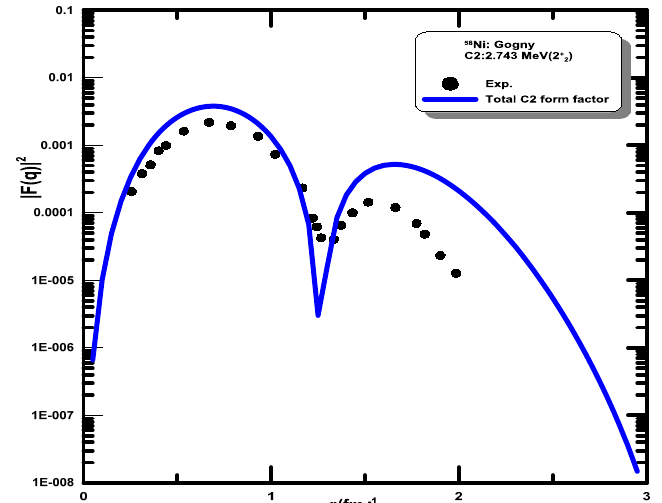
Fig.3: Inelastic longitudinal C2 form factors for the state ( E with residual interaction M3Y (solid curve), experimental data (filled circle) are taken from Ref. [18].